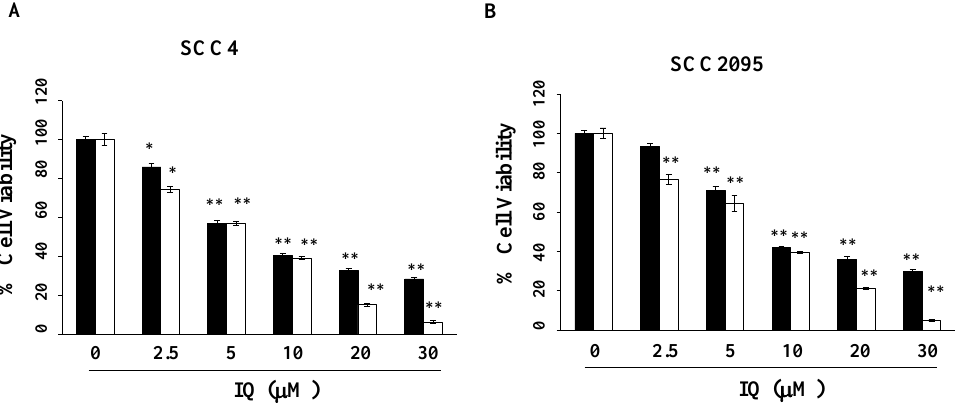
Figure 1. E ff ect of ilimaquinone (IQ) on the viability of oral cancer cells (SCC4 and SCC2095). ( A ) SCC4 and ( B ) SCC2095. The cells were seeded onto 96-well plates, incubated for 24 ( (cid:4) ) and 48 h ( (cid:3) ), treated with IQ for 48 h and then cell viability was detected using the 3-(4,5-dimethylthiazol-2-yl)-2,5-diphenyltetrazolium bromide (MTT) assays. Points, means; bars, S.D. ( n = 3–6). * p < 0.05 and ** p < 0.01 vs. the control